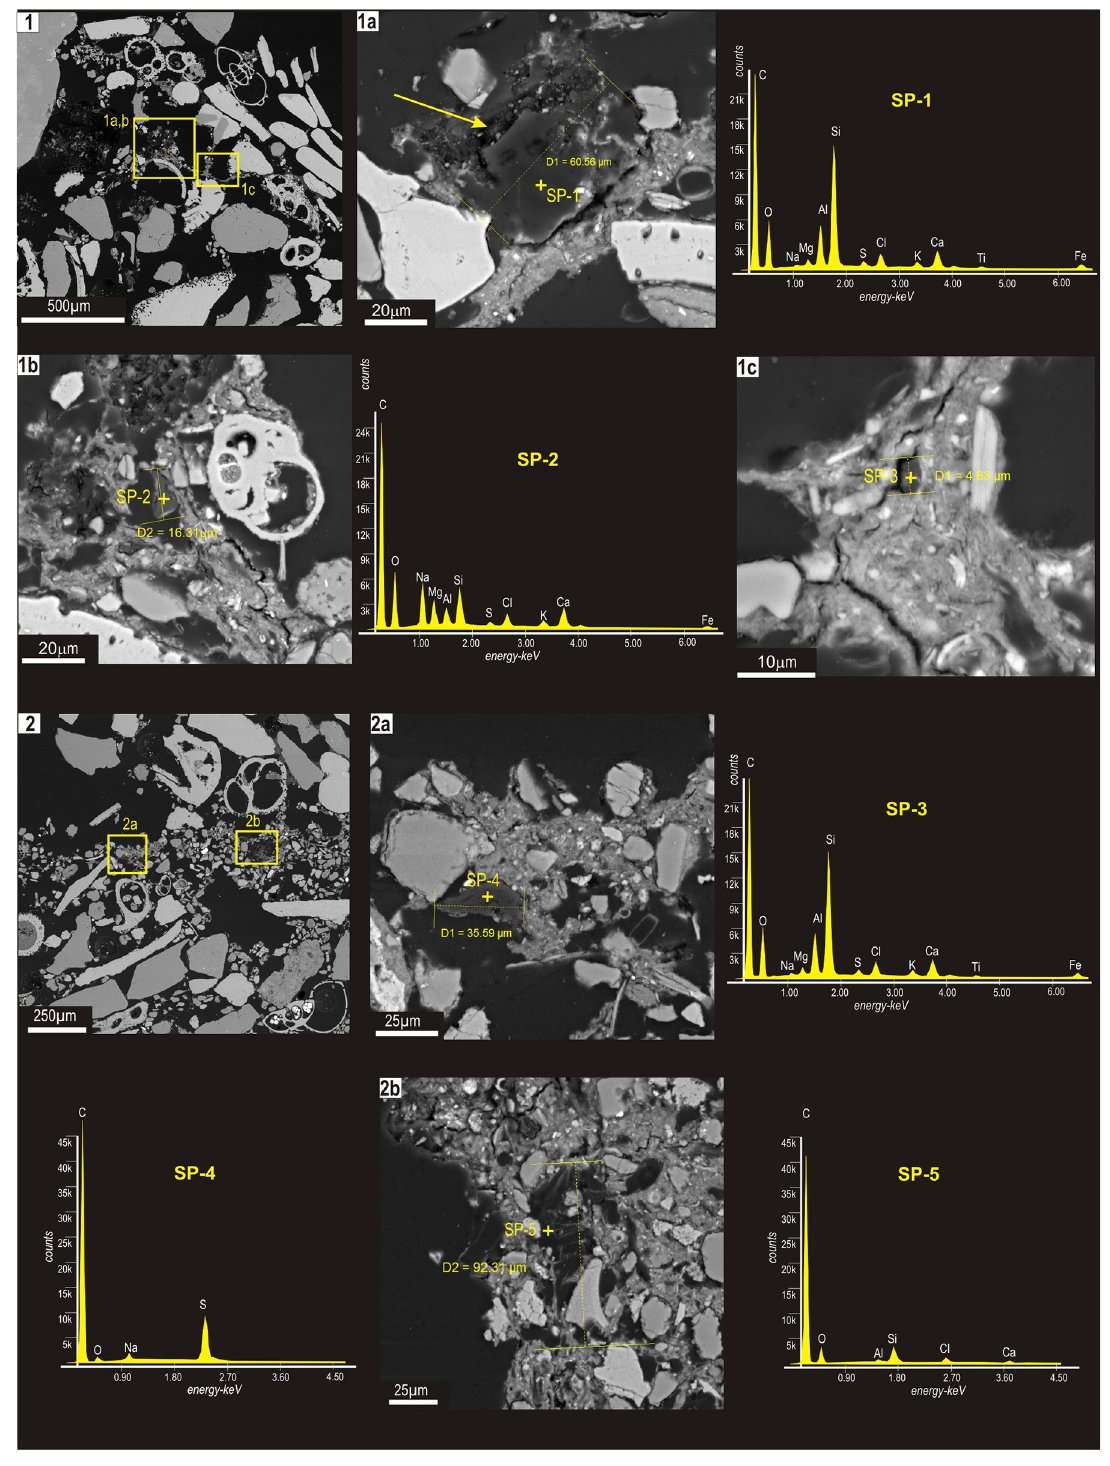
Fig 4. BSE images of microplastic particles and compositional spectra found in sectioned tubes from both sites.